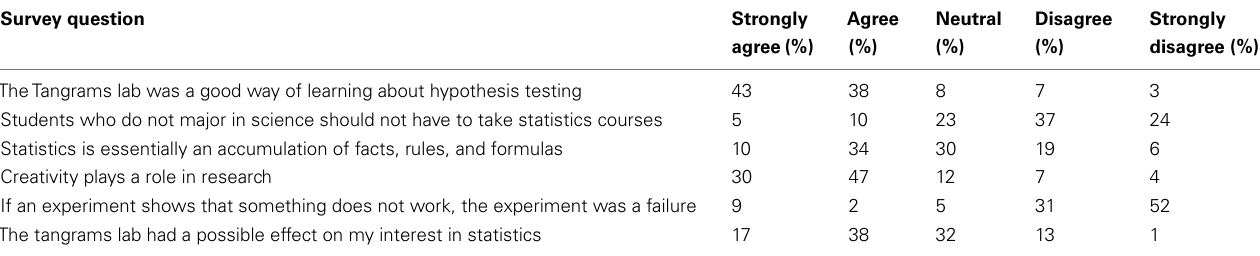
Table 6 | Survey results for 115 students after completing theTangrams